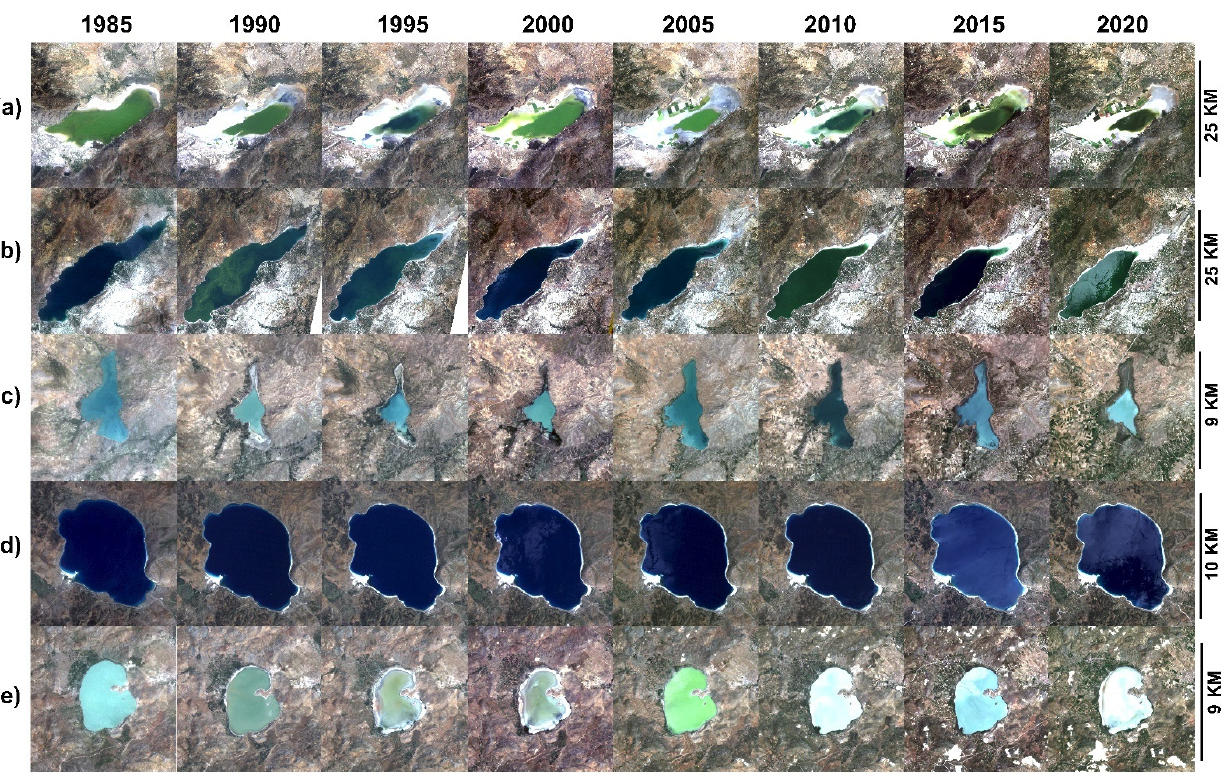
Figure 4. Change in the surface area of lakes: ( a ) Ac ı göl, ( b ) Burdur, ( c ) Karata ş , ( d ) Salda, and ( e ) Yar ı ş l ı for wet periods from 1985 to 2020.